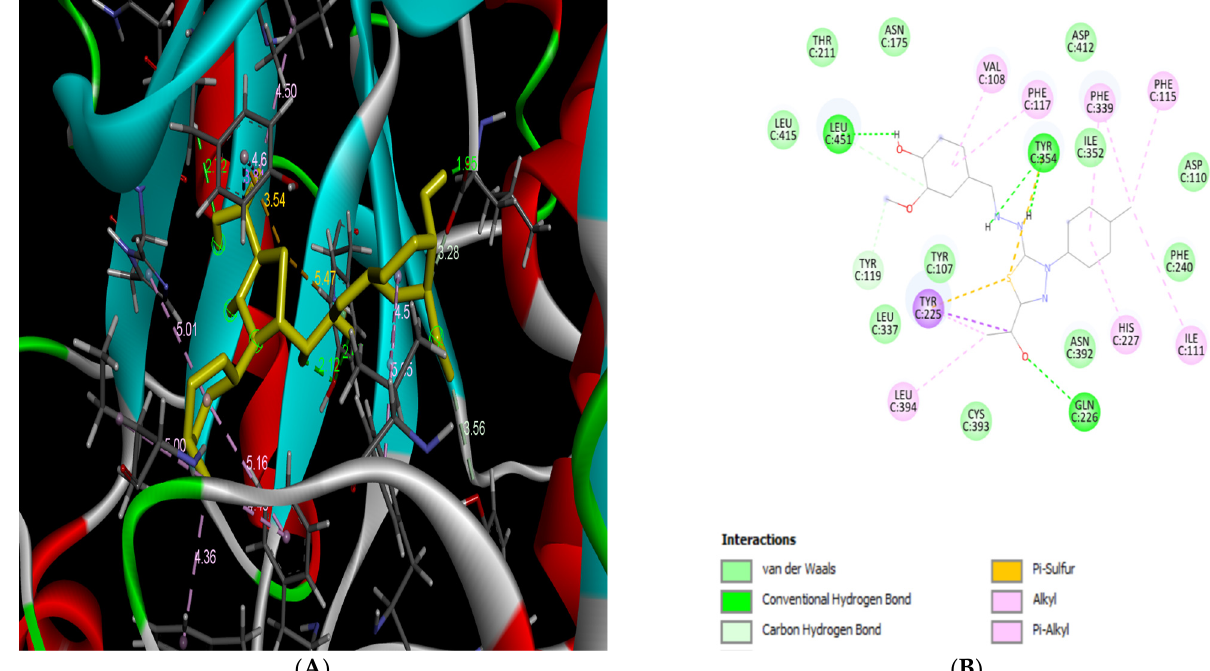
Figure 7. 2D ( B ) and 3D ( A ) representation of compound 3 docking with Nmt.